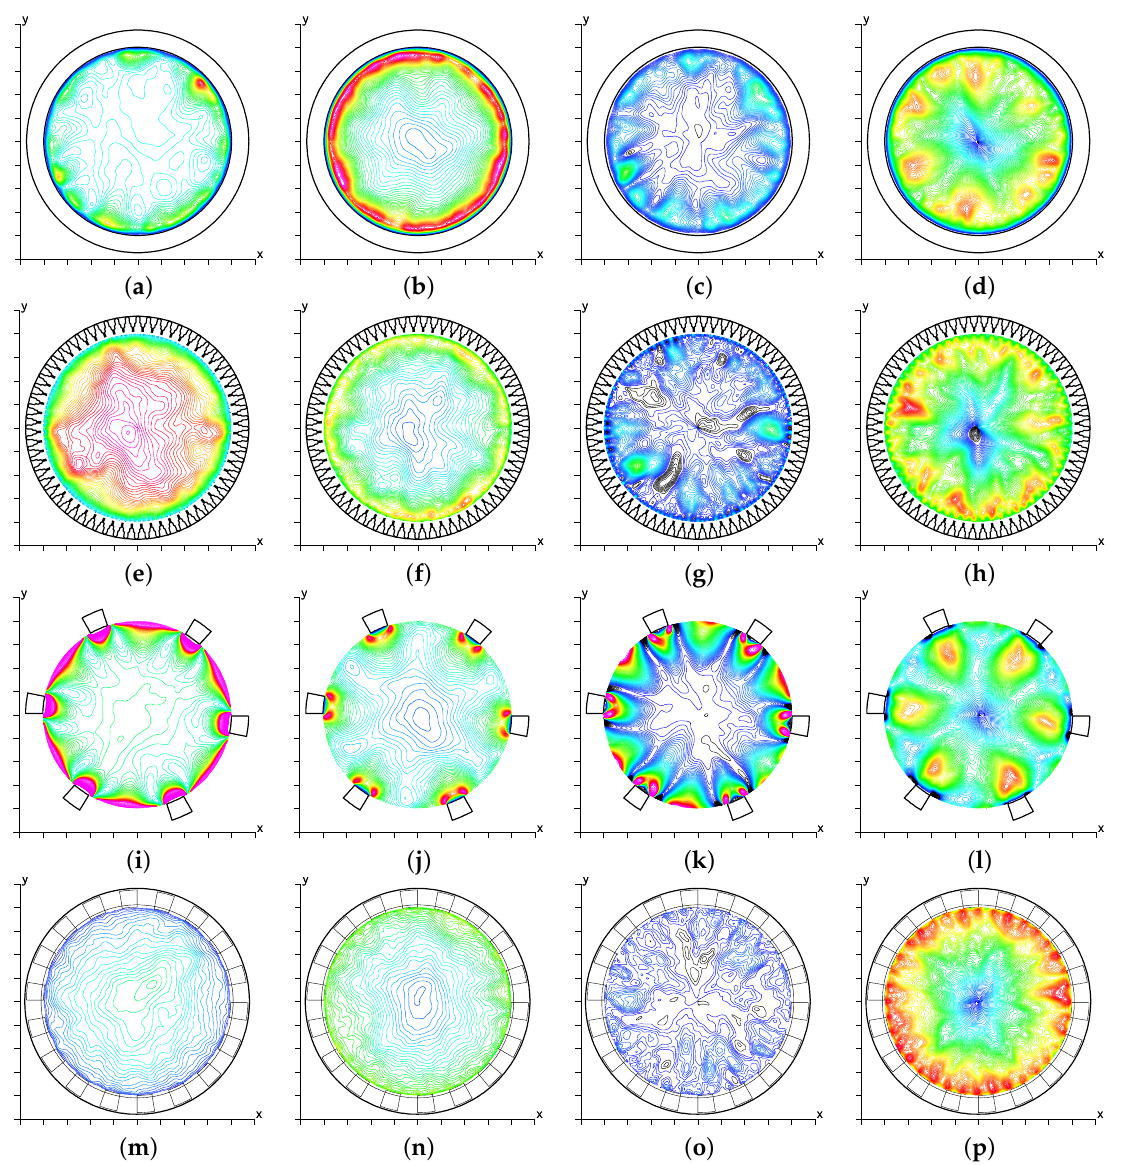
Figure 7. Contour plots of inner-scaled coherent axial stresses ρ + zz ( a , e , i , m ), incoherent axial stresses R + zz ( b , f , j , n ), coherent shear stresses ρ + rz ( c , g , k , o ), and incoherent shear stresses R + rz ( d , i , l , p ), for different types of wall corrugations ( Re = 6534): smooth pipe ( SM ): ( a – d ); triangular bars ( TLS ): ( e – h ); rectangular bars ( SLL ): ( i – l ); and staggered cubes ( CS ): ( m – p ). Positive contours from blue to red, negative in black, with increment ∆ + = 0.01 for ρ + rz and R + rz , and ∆ + = 0.1 for ρ + zz and R + zz